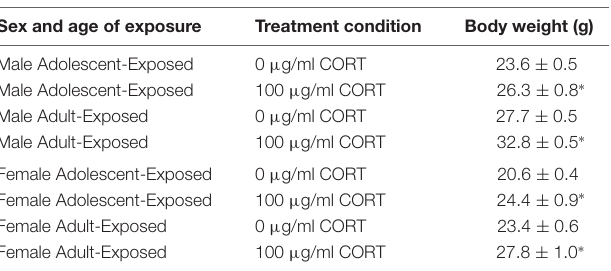
Asterisks indicate a significant difference between the 0 µ g/ml and 100 µ g/ml treatment conditions. Note that the significant main effects for age of exposure in Experiments 3 and 4 are not